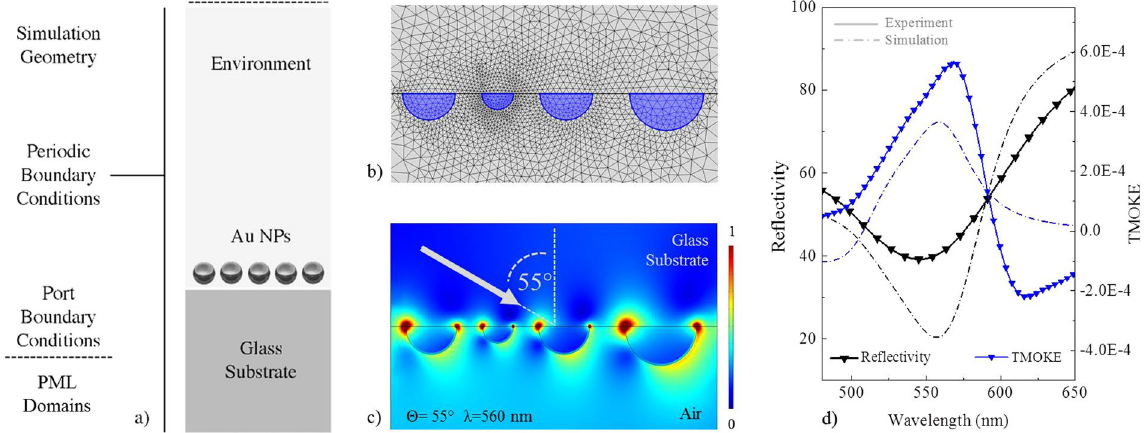
Figure 5. ( a ) Simulation geometry for an ordered array of Au NPs deposited on a glass substrate; ( b ) Free triangular mesh distribution used for the discretization of the simulation domain with a local refinement on plasmonic NPs; ( c ) A 2D plot of the Electric field Norm distribution calculated at the resonance frequency of the system for an incident angle of 55°. A great enhancement of the E field can be noticed near particles surface when the LSPR is activated; ( d ) Comparison of theoretical (dash dot line) and experimental (solid line) results obtained in Kretschmann configuration at an incident angle of 55° degree; in particular, the optical (black line) and MO (blue line) spectra of the analysed system have been